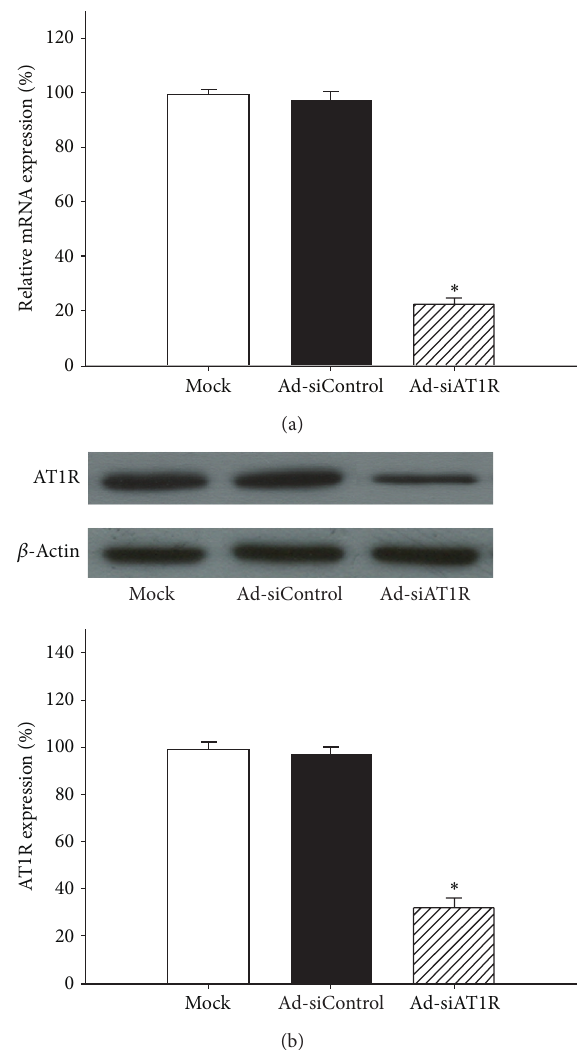
Figure 2: Effects of AT1R silencing on AT1R expression. (a) Islets of db/db mice were transfected with Ad-si AT1R, Ad-siControl, or Mock and cells were cultured for 72 h prior to quantitative RT- PCR. Results are represented as mean ± SD for six independent experiments. ∗ 𝑃 < 0.05 versus Ad-siControl. (b) Islets of db/db mice were transfected with Ad-si AT1R, Ad-siControl, or Mock and cells were cultured for 72 h prior to quantitative immunoblot evaluation.Resultsarerepresentedasmean ± SDforsixindependent experiments. ∗ 𝑃 < 0.05 versus Ad-siControl.